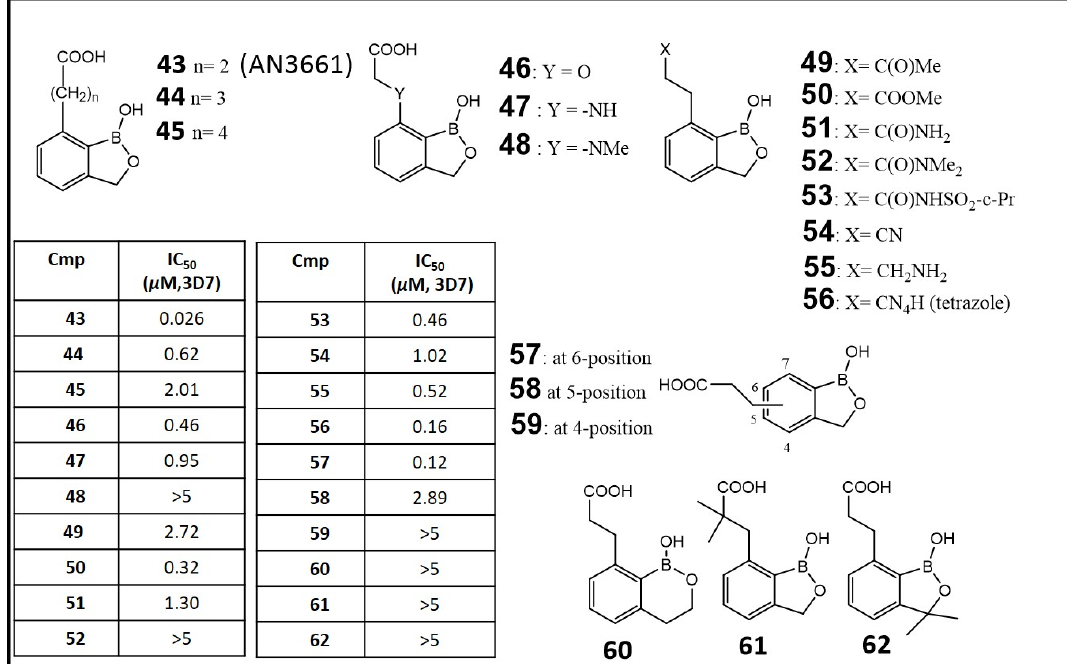
Figure 6. Structures and antimalarial activity (IC 50 ) of benzoxaborales ( 43 – 62 ) against the malaria parasite Plasmodium falciparum CQ-sensitive 3D7 strain. (Adapted from